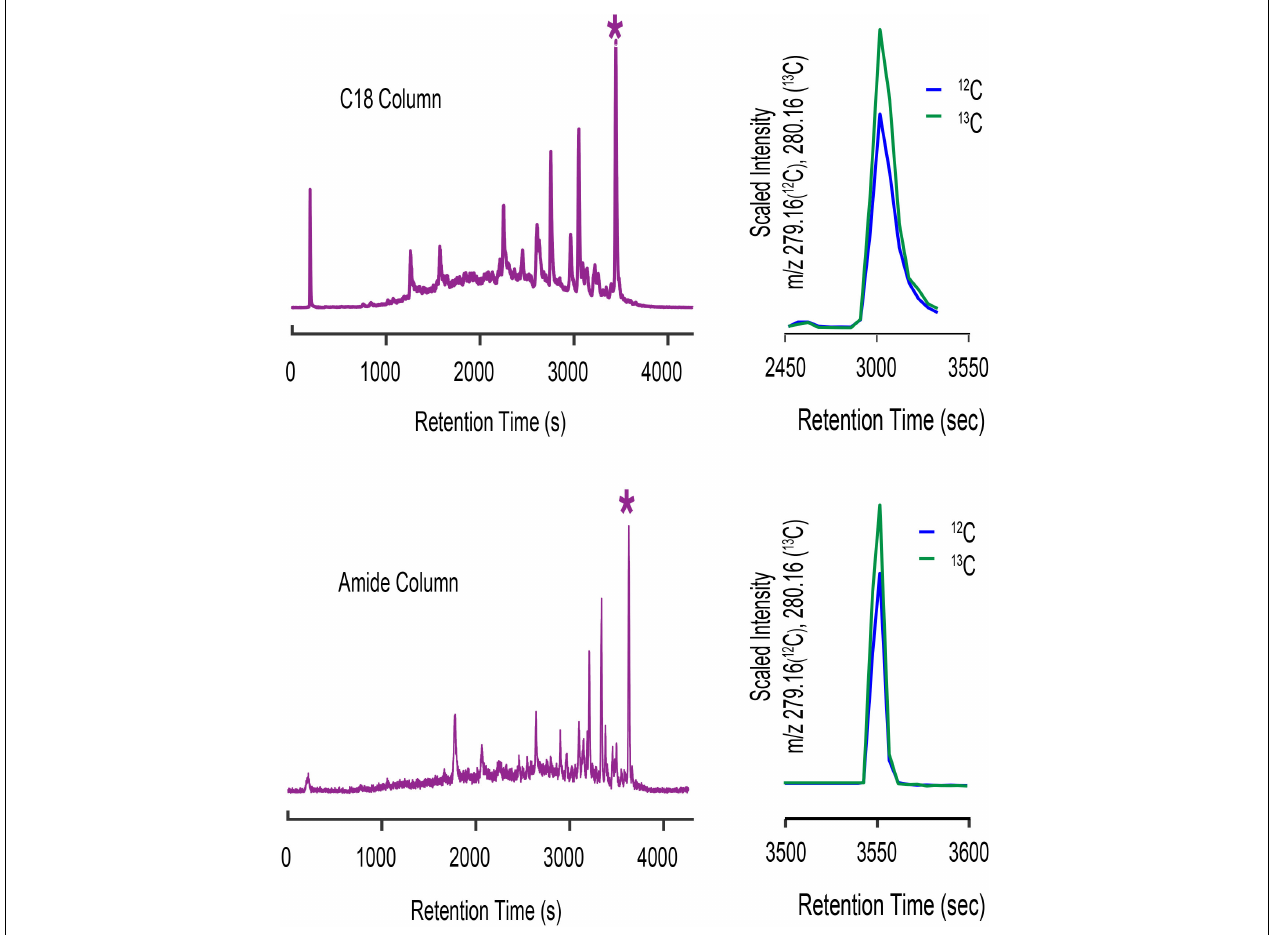
FIGURE 11 | LC-ICPMS 127 I-chromatogram of organic iodine metabolites in spent media from a culture of Prochlorococcus MIT9215 separated on a C18 column (top, let) and an amide column (bottom, left) . The complex mixture of organic iodine metabolites shown in the chromatograms is typical of culture media and seawater samples. When the ESIMS data of the starred (*) peak from each analyses are processed with CMA-T and CMA-C we only find one target ion at 279.16 D (top and bottom, right) that is common to both